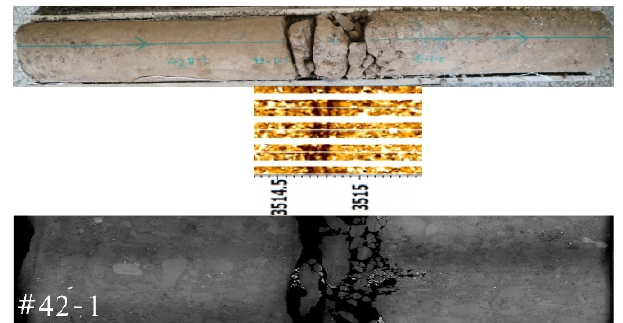
Figure 2. Features of a hydraulic fracture.